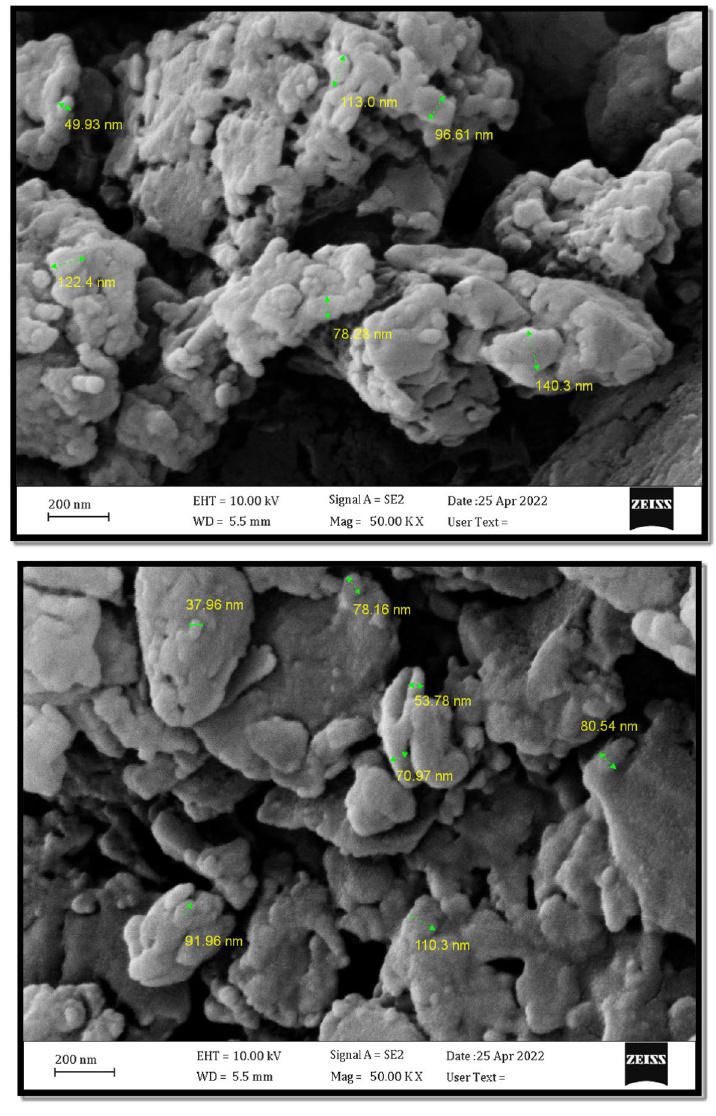
Figure 4. FESEM images of the Fe 3 O 4 /SiO 2 -TMA-Me nanocomposite ( 1